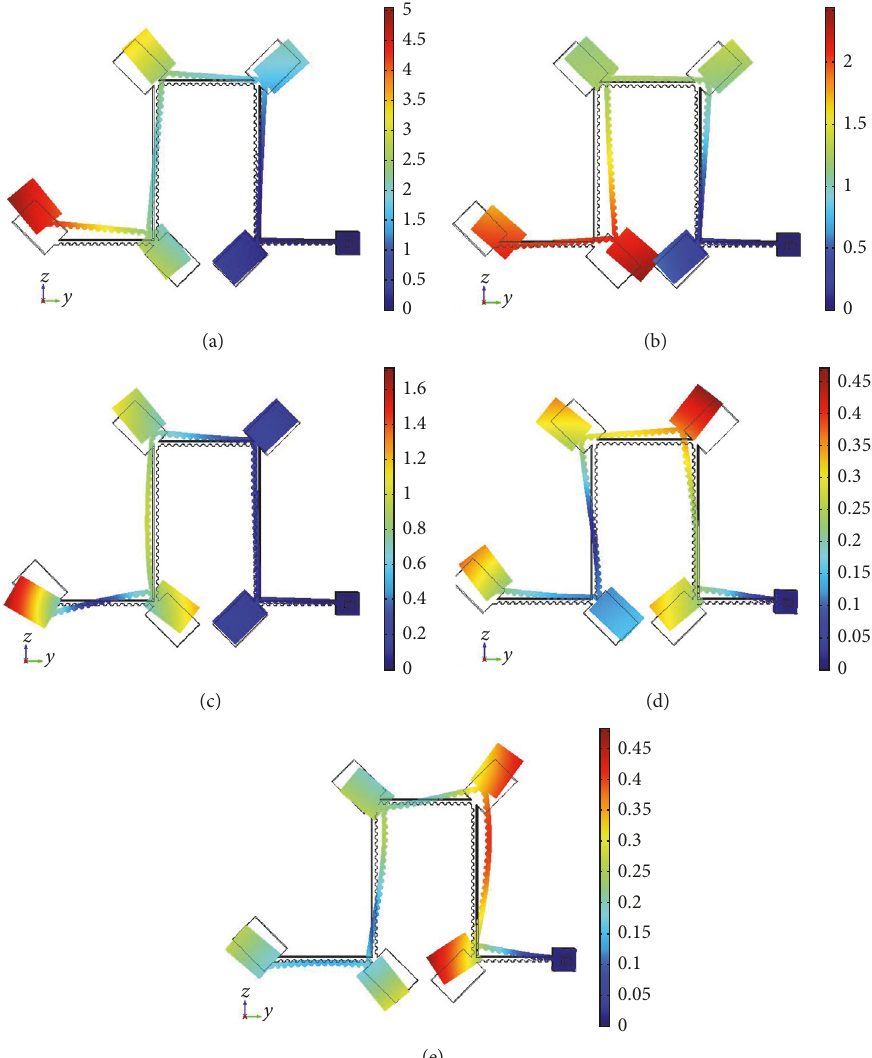
Figure 3: Modal shapes of the harvester; (a) 𝑤 𝑛1 = 24.95 Hz; (b) 𝑤 𝑛2 = 47.49 Hz; (c) 𝑤 𝑛3 = 170.9 Hz; (d) 𝑤 𝑛4 = 229.3 Hz; (e) 𝑤 𝑛5 = 298.15 Hz.